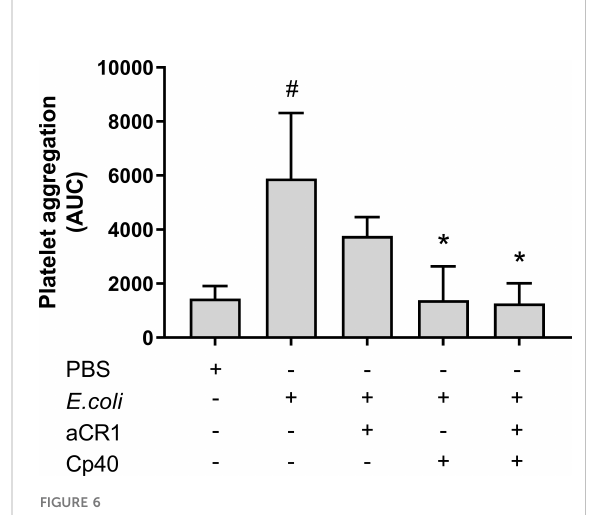
FIGURE 6 The effect of a blocking complement receptor (CR)1 antibody on Escherichia coli ( E. coli 5.3 x 10 9 /mL)-induced platelet aggregation measured on Multiplate ® impedance aggregometry. To the samples were added phosphate-buffered saline (PBS) control, compstatin (Cp40, 20 µM), blocking CR1 antibody (4 ng/ mL) or a combination of both, and PBS or E. coli as activators. Results are given as the area under the curve (AUC), using mean ± standard deviation (n = 7). #; p < 0.05 analyzed using a paired Student ’ s t-test between the samples with and without E. coli , *; p < 0.05 analyzed using one-way ANOVA repeated measurements, and Dunnett ’ s multiple comparisons test, comparing E. coli -activated samples with and without